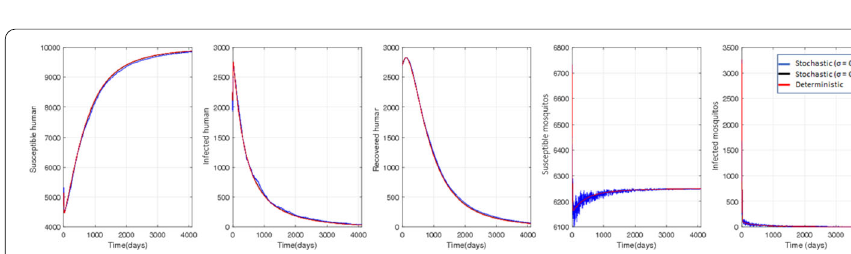
Figure 7 Model simulation with fumigation and without bed nets when R 0 < 1